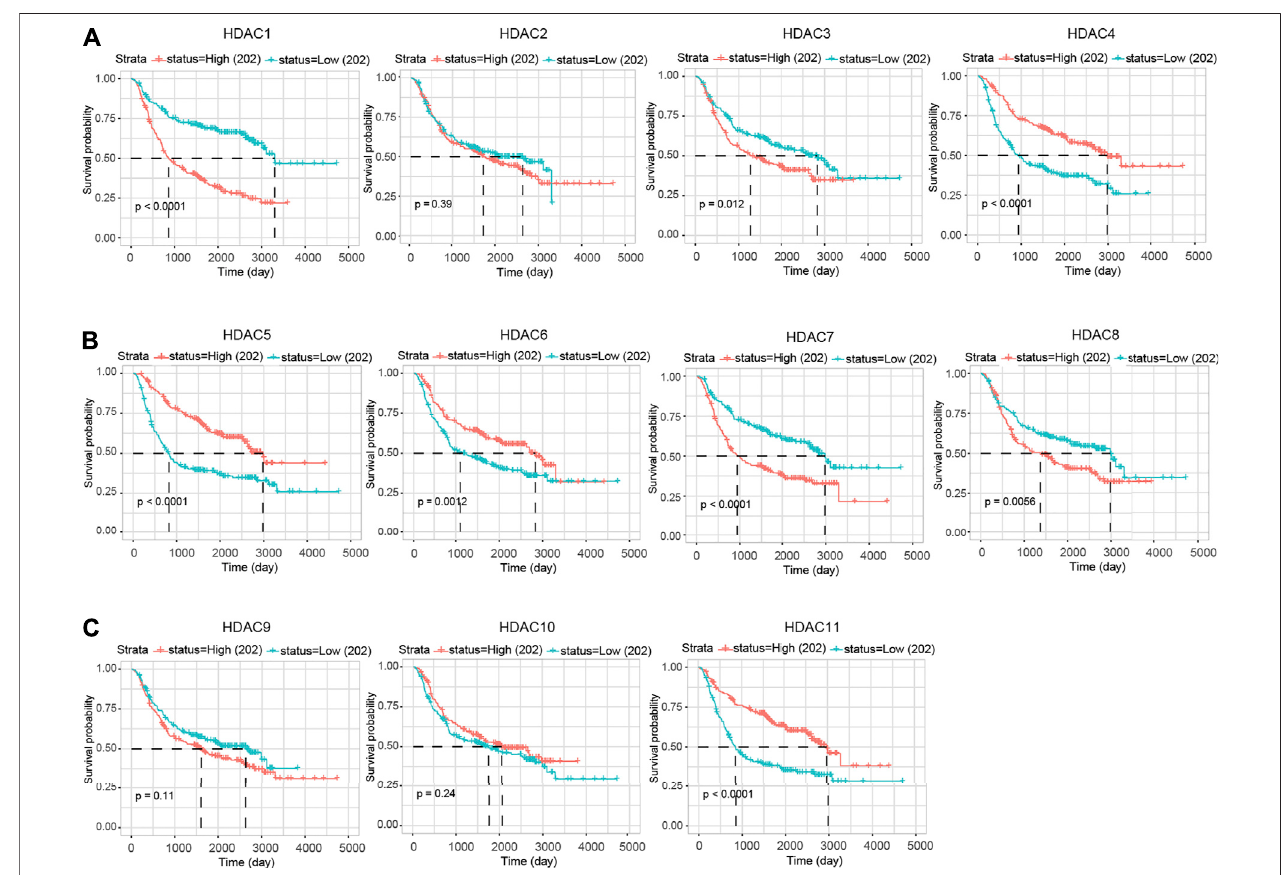
FIGURE 6 | Prognostic feature (OS) of HDAC family in glioma based on CGGA. (A – C) The KM survival analysis was performed for veri fi cation regarding the prediction ef fi ciency of the HDAC